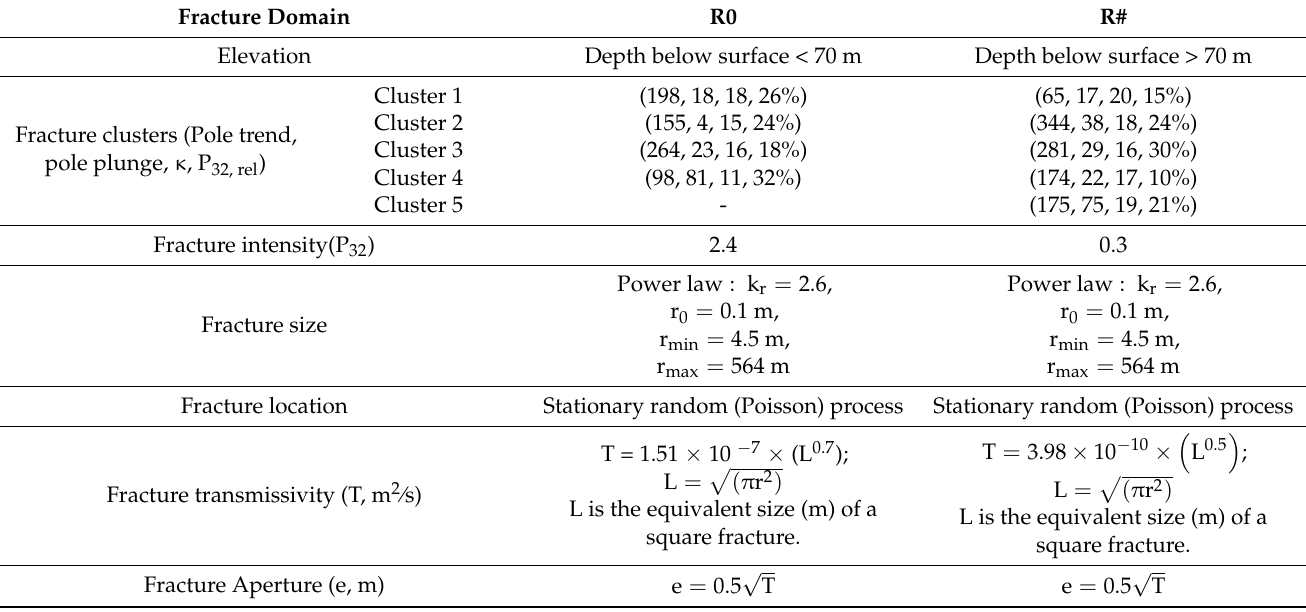
Table 2. The DFN recipe for R0 and